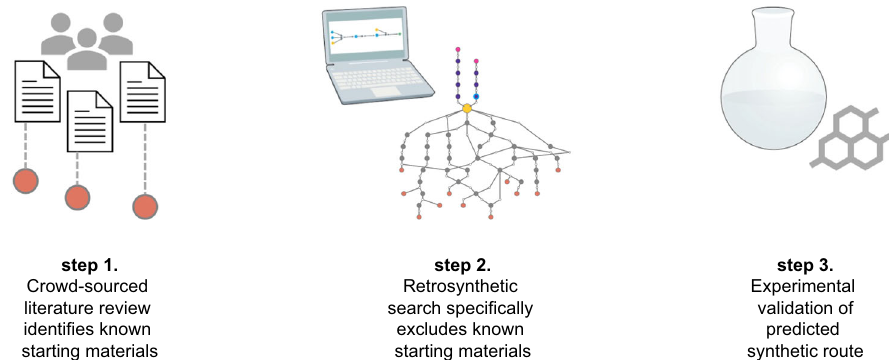
Fig. 1 Work fl ow to identify alternate starting material supply chains. 1. Published starting materials are encoded as SMILES strings, which are 2. excluded from automated retrosynthetic searching. 3. Select routes are validated in the